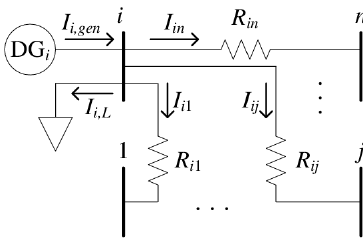
Figure 2. DC power system composed with bus i and its adjacent buses.